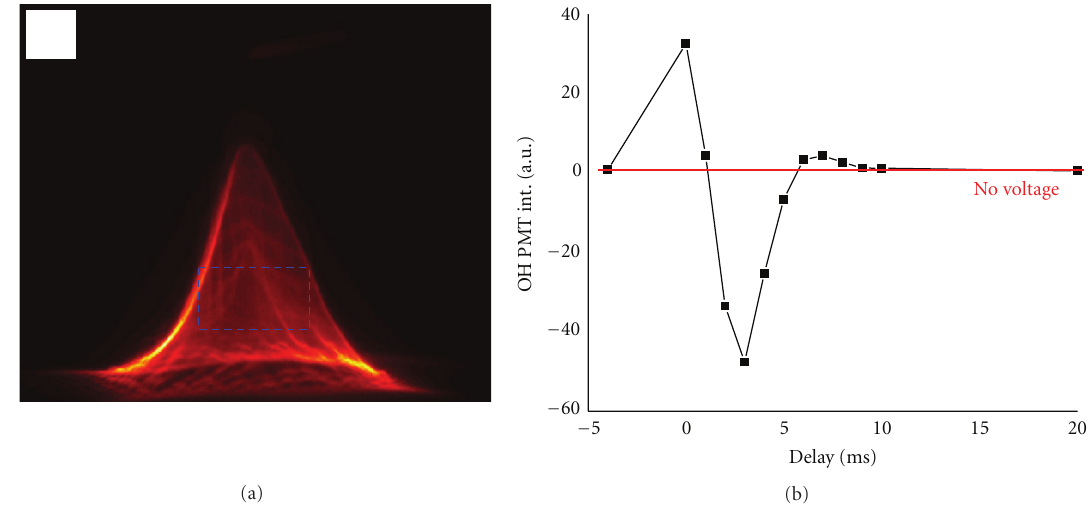
Figure 8: Plot of temporal response of OH chemiluminescence intensity. Impulse behavior, showingan initial increase in OH (A-X) emission intensity, exhibits similarities to thermoacoustic